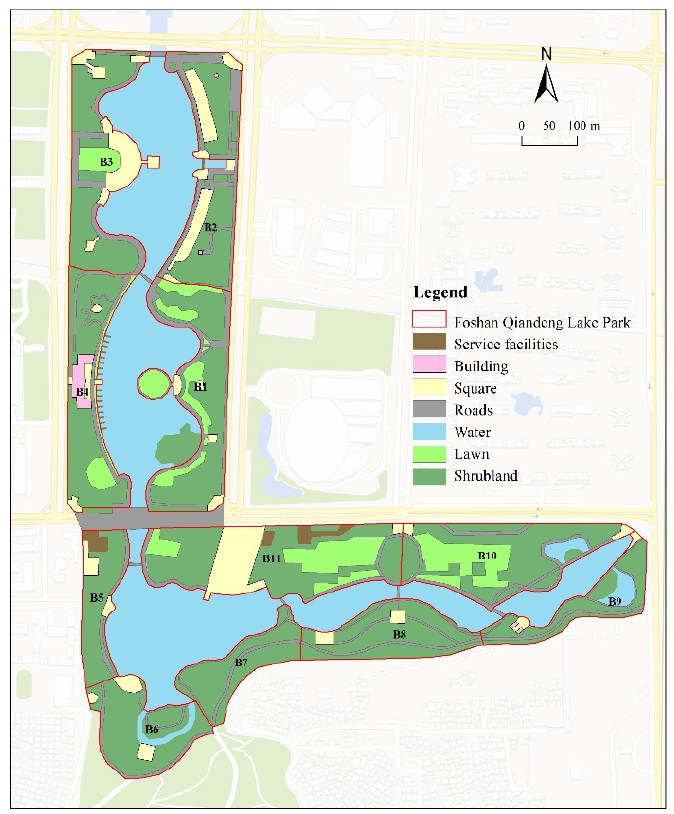
Figure 2. Landscape distribution map of Qiandeng Lake Park in Nanhai District, Foshan City.